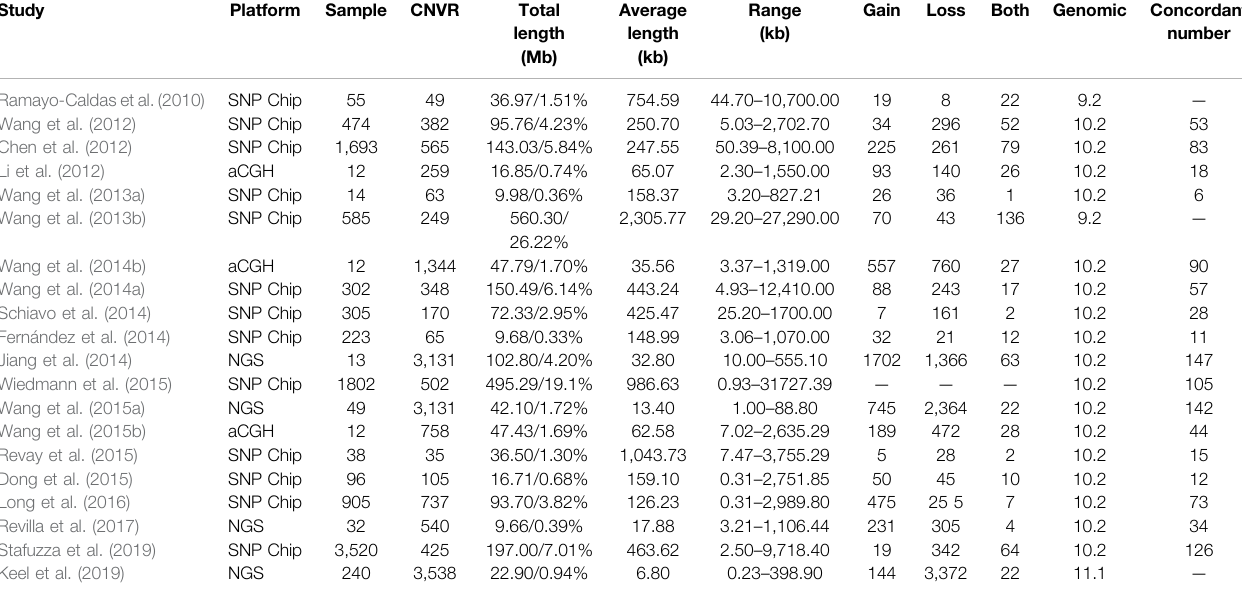
TABLE 4 | Comparison of CNVRs identi fi ed in this study with previous studies.